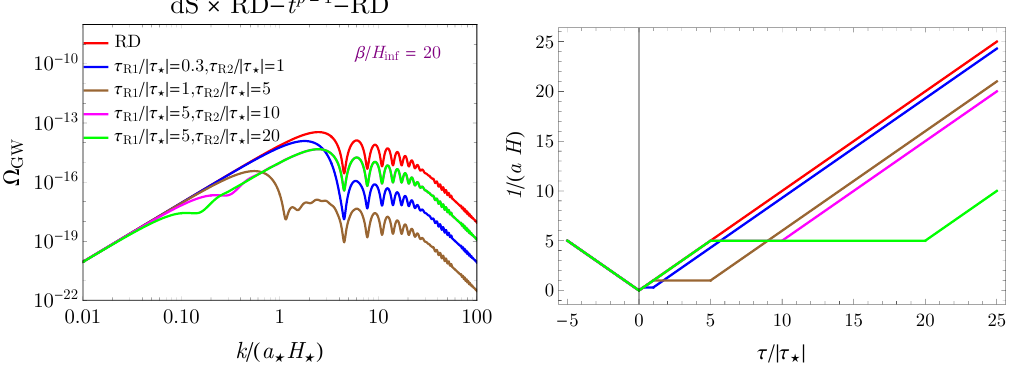
Figure 10 . GW spectrum from first-order phase transition during the quasi-de Sitter inflation, with the post-inflationary RD − t ˜ p =1 − RD scenario. The intermediate t ˜ p =1 stage corresponds to the cosmic string dominated era. The red curve corresponds to the dS × RD scenario. The curves with other colors are for different ratios of τ R / | τ ? | and τ R / | τ ? | , 1 2